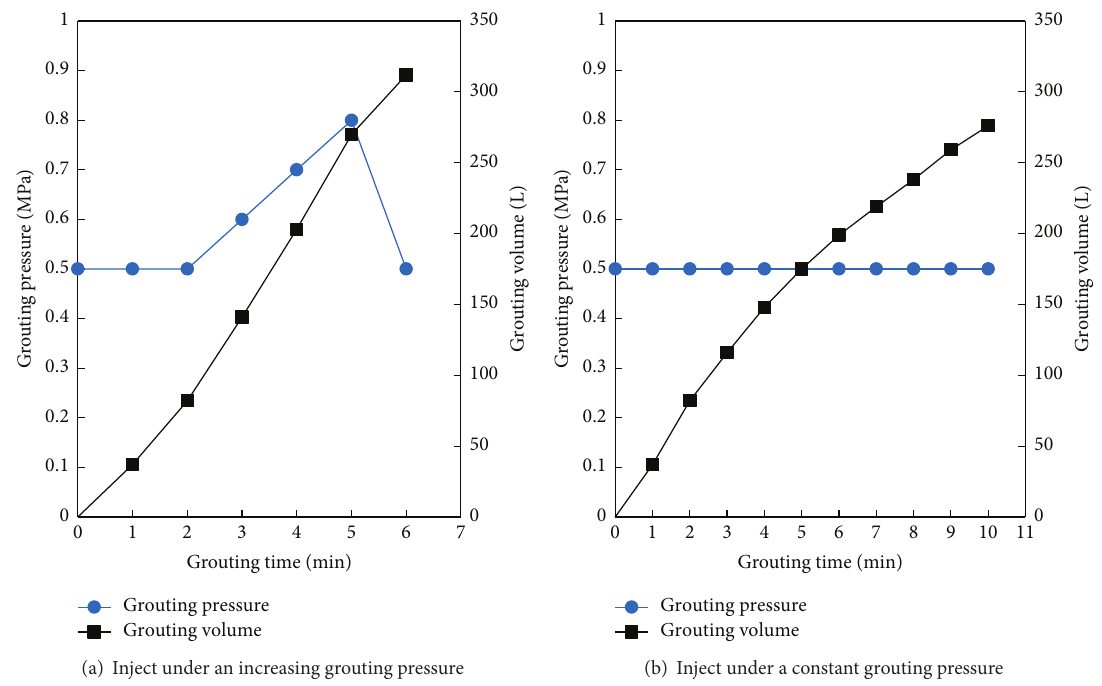
Figure 10: The typical grouting process of C1 and A1.